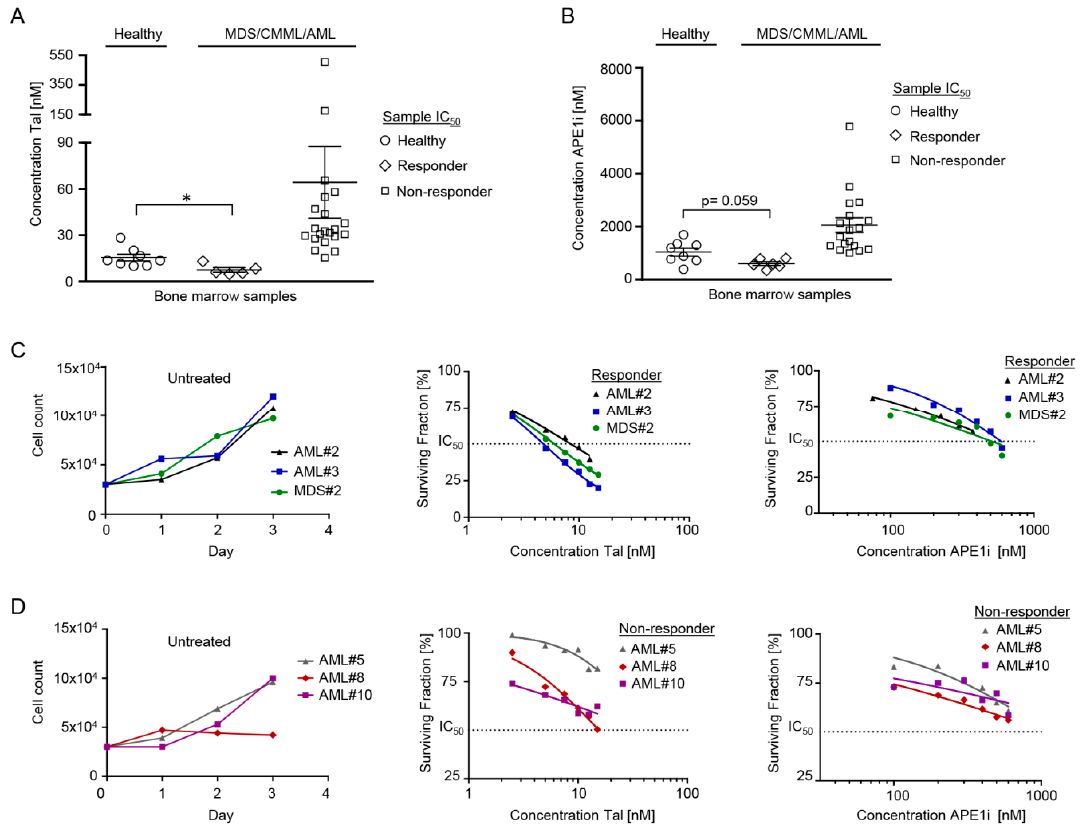
Figure 1. Cytotoxic efficacy of talazoparib and APE1 inhibitor III in healthy CD34+ donor cells, in CD34+ myelodysplastic syndrome (MDS)/chronic myelomonocytic leukemia (CMML) cells, and in CD34+ or CD34 − acute myeloid leukemia (AML) cells after initial expansion for 3 days followed by 3 days of treatment. ( A ) The mean IC 50 of talazoparib was significantly lower (* p = 0.016) in 1 MDS (MDS#2), 1 CMML (CMML#2), and 3 AML cell samples (AML#1, AML#2, AML#3) as compared to 8 healthy donor cell samples. ( B ) The mean IC 50 of APE1 inhibitor III was substantially lower ( p = 0.059) in 1 MDS (MDS#2) and 5 AML cell samples (AML#1, AML#2, AML#3, AML#6, AML#12) as compared to 8 healthy donor cell samples. ( C ) Exemplary growth curves (left panel) and corresponding surviving fractions of 3 ‘responders’ after initial expansion for 3 days followed by 3 days of treatment with talazoparib (mid panel) and APE1 inhibitor III (right panel). ( D ) Exemplary growth curves (left panel) and corresponding surviving fractions of 3 ‘non-responders’ after initial expansion for 3 days followed by 3 days of treatment with talazoparib (mid panel) and APE1 inhibitor III (right panel). Error bars represent mean ± standard error of mean.